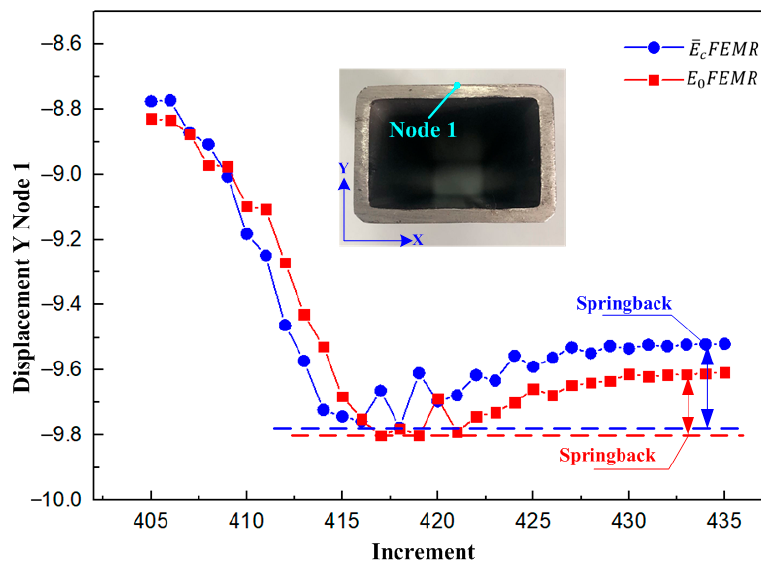
Figure 15. Comparison of springback simulation results of the 𝐸 (cid:2868) 𝐹𝐸𝑀𝑅 and the 𝐸(cid:3364) (cid:3030) 𝐹𝐸𝑀𝑅 . Table 6. Comparison of springback results in roll forming.